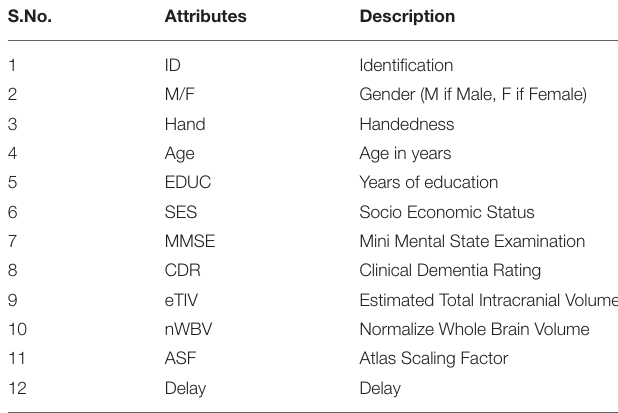
TABLE 2 | Dataset